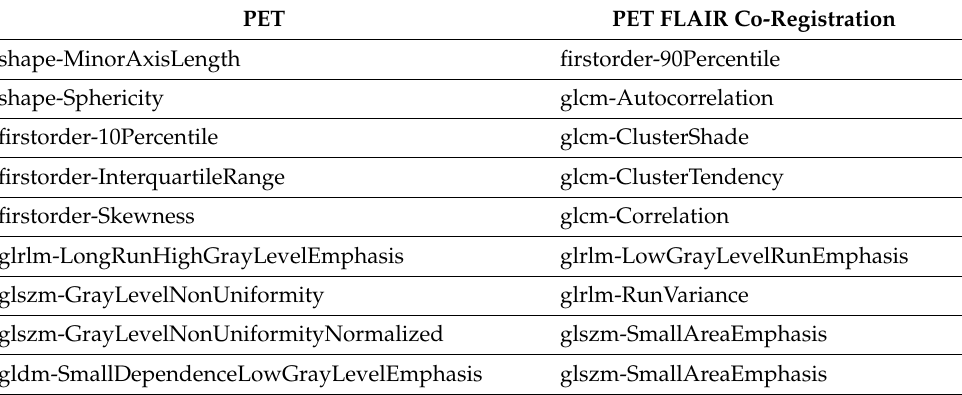
Table 2. The different features selected in PET and PET co-registered with FLAIR datasets.